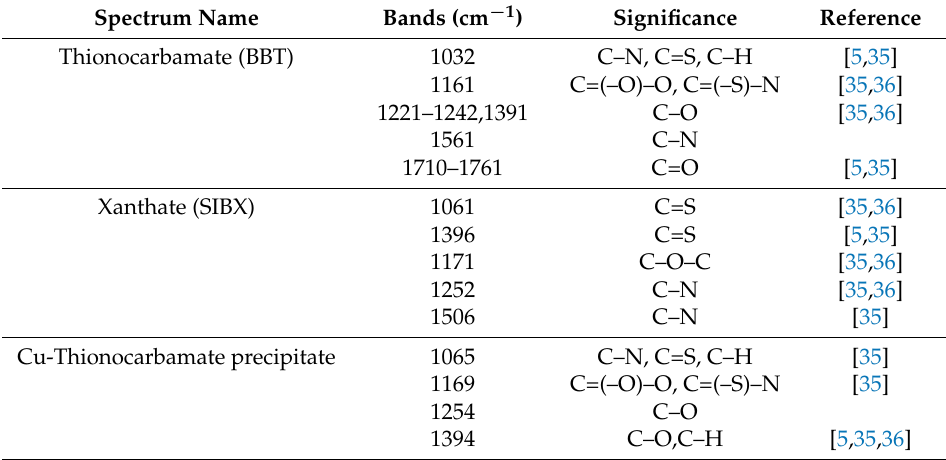
Table 2. Summary of Fourier transform infrared (FTIR) bands of thionocarbamate, Cu-thionocarbamate precipitate, xanthate.